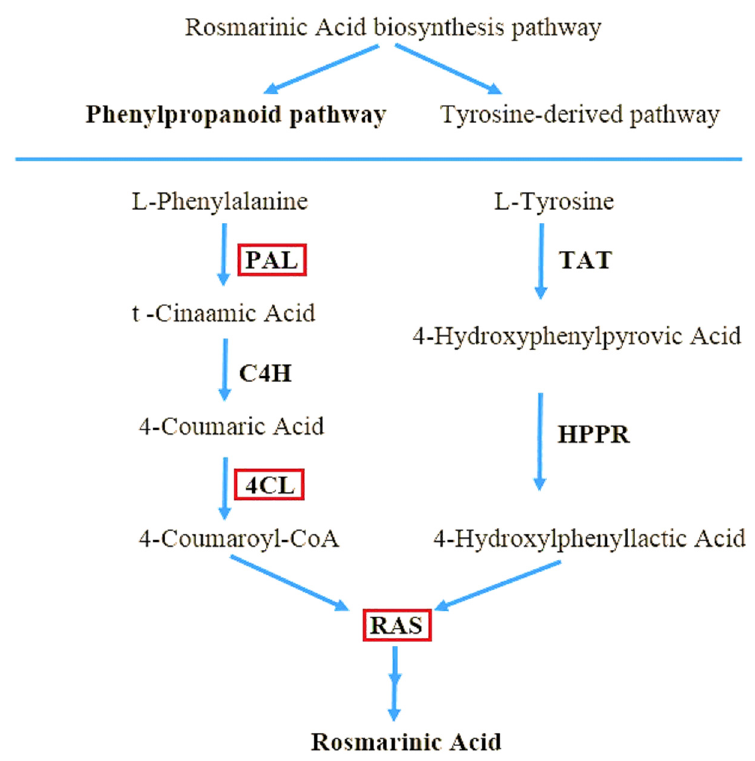
Figure 1. A rectangle is placed above enzyme genes that have been investigated in Iranian lemon balm including Phenylalanine ammonia ‐ lyase (PAL), 4 ‐ Coumarate ‐ CoA ligase (4CL), Rosmarinic acid synthase